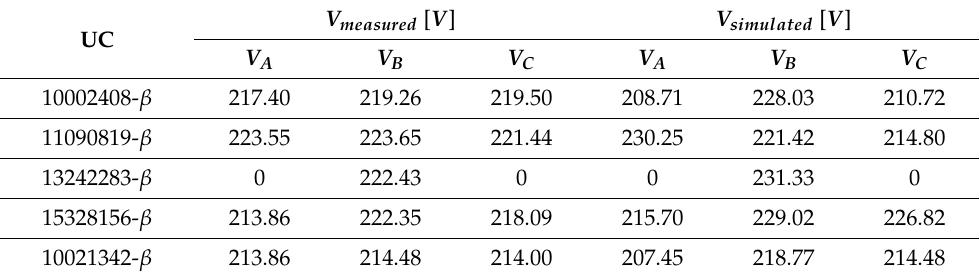
Table 13. Average values × simulated values with pf =